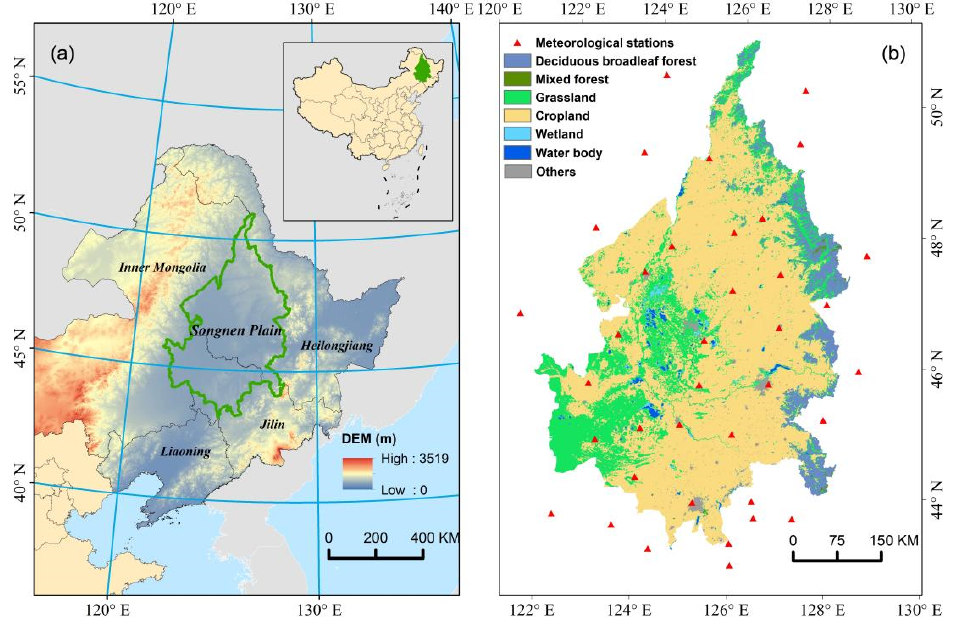
Figure 1. ( a ) Location of the study area with DEM, ( b ) land cover type